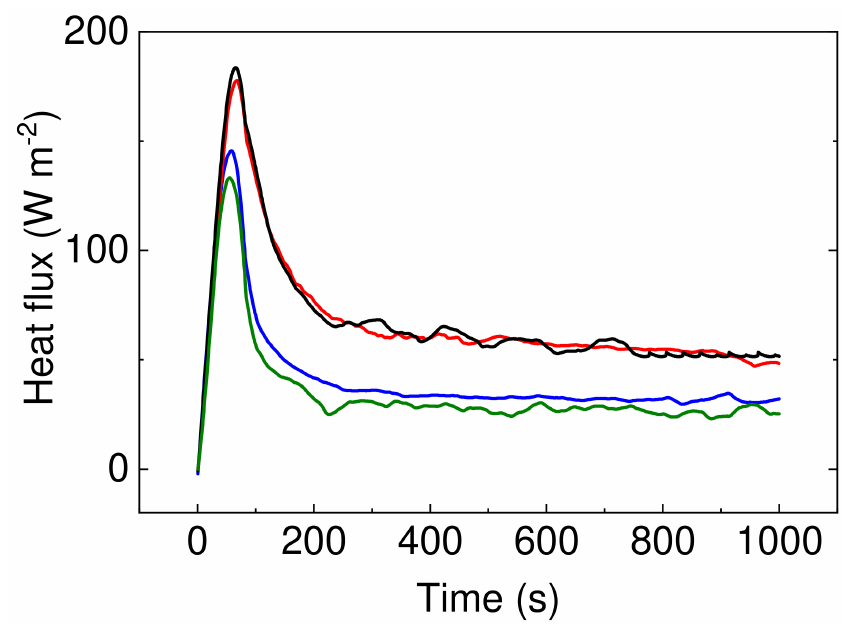
Figure 9. Heat flux development over the period of time upon 40 ◦ C stimulation. Sample P05 is black line, P1 is red line, PW1 is blue line, and PW05 is olive